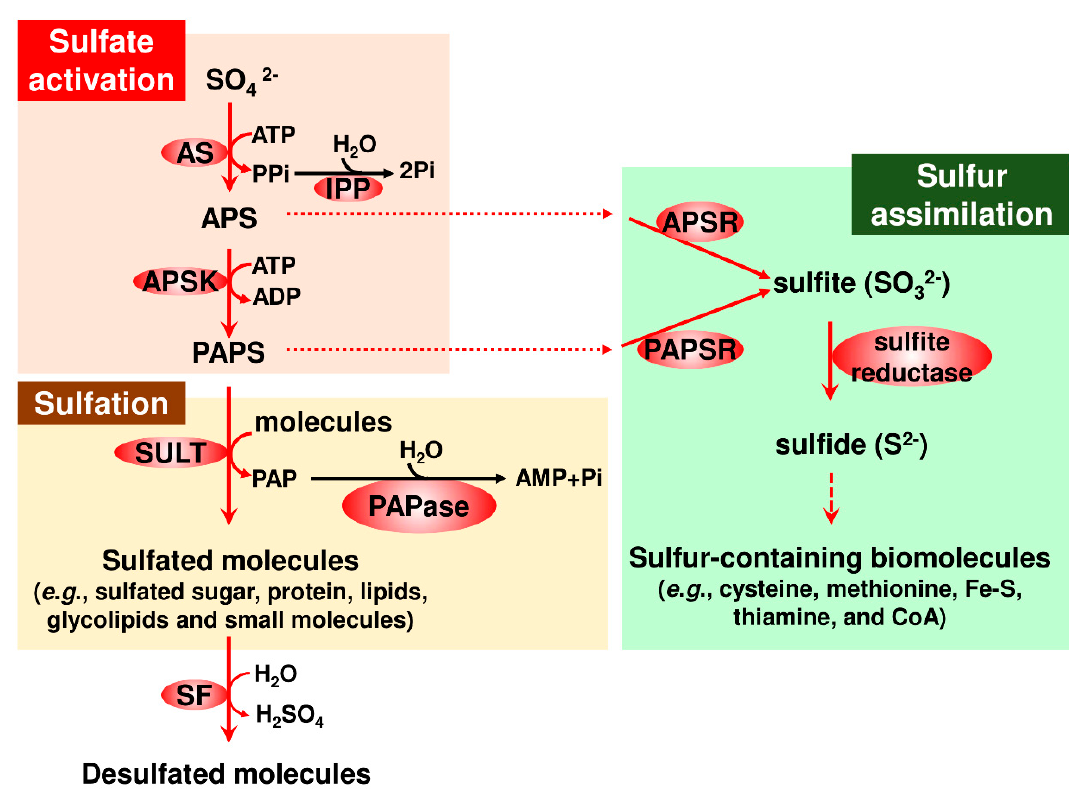
Figure 1. Overview of sulfate metabolism functionally linked to sulfate activation. An overall metabolic pathway is depicted, in which information from bacterial to human studies is integrated. Note that Entamoeba does not possess genes encoding APS and PAPS reductases (AmoebaDB; KEGG). The enzyme responsible for each step is shown by a filled oval. Abbreviations used: APS, adenosine 5 ′ -phosphosulfate; APSK, APS kinase; AS, ATP sulfurylase; IPP, inorganic pyrophosphatase; PAP, adenosine 3 ′ ,5 ′ -bisphosphate; PAPase, 3 ′ (2 ′ ),5 ′ -bisphosphate nucleotidase; PAPS, 3 ′ -phosphoadenosine 5 ′ -phosphosulfate; Pi, inorganic phosphate; PPi, inorganic pyrophosphate; SF, sulfatase; and SULT, sulfotransferase. Enzymatic reactions are indicated by arrows. Multiple steps for synthesizing sulfur-containing biomolecules is simplified by dashed arrow. Fine dotted lines indicate molecular transfer of APS and PAPS.